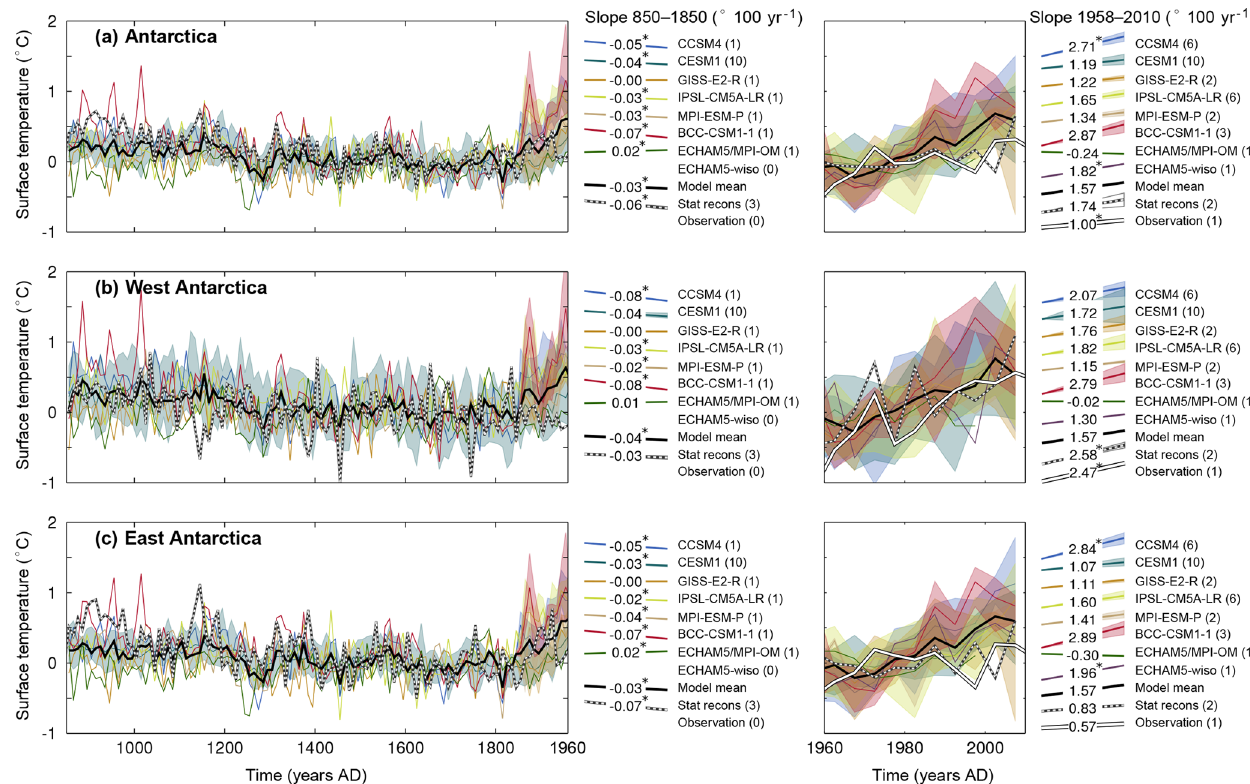
Figure 1. Changes in 10- (left panels) and 5-year averaged (right panels) surface temperature over the 850–2000CE period over (a) Antarc- tica, (b) West Antarctica and (c) East Antarctica (for a definition of the regions see Stenni et al., 2017). The model results are shown using the colored lines, the average of the three statistical reconstructions of Stenni et al. (2017) is shown using a dashed black and white line, and the reconstruction based on instrumental records (Nicolas and Bromwich, 2014) is shown using a white line (in the right panels only). The number of ensemble members for each model is given in brackets after the labels. The colored shading represents the mean ± 1 standard deviation of the corresponding ensemble. The reference period is 1500–1800CE for the left panels, and 1960-1990CE for the right panels. The mean slopes (in degree/100 years) over the 850–1850 and 1958–2010CE periods are shown to the right of each panel; slopes propor- tional to the numbers are also displayed. When the trends of all available members are significantly different from zero according to F tests ( p < 0 . 05), the mean slope values are followed by an asterisk ( ∗